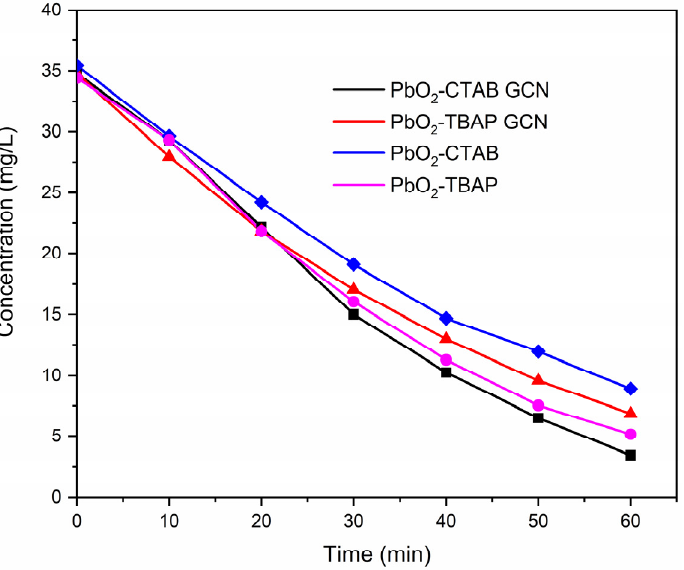
Figure 7. Degradation of RB5 dye under pH 2, Na 2 SO 4 concentration of 0.15 M, I = 0.17 A, RB5 concentration of 35 mg/L, using different anodes.